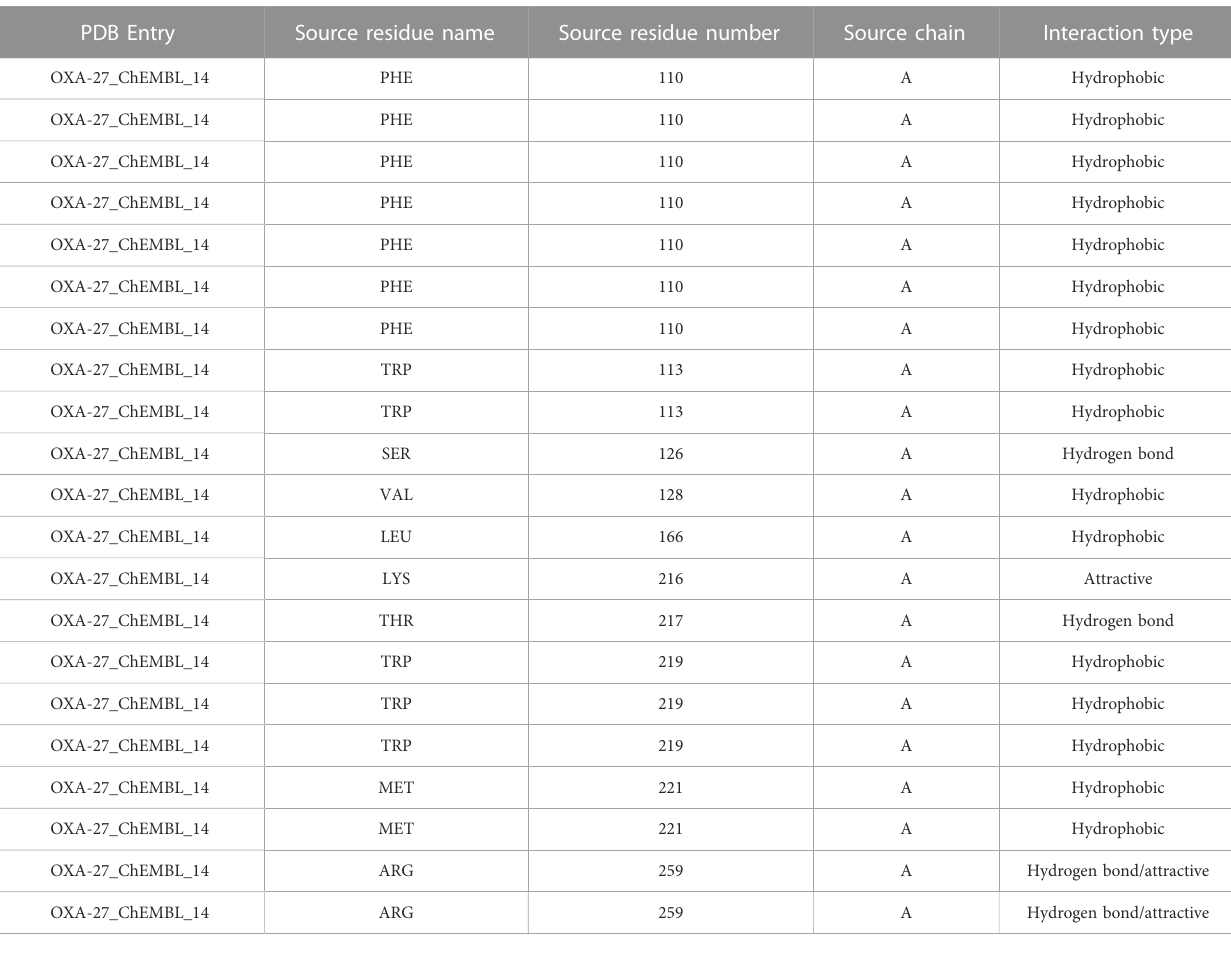
loop 1, Ser252 — Ser109 from loop 2, and Ser109 — Lys224 from loop 3 (residues taken for the measurement purpose) are shown in Figure 4. The distance of starting coordinates and initial, middle, and fi nal frames of the molecular dynamics simulation are shown in Table 6. This study suggests that the protein tends to have a wide loop opening in the absence of meropenem. The distance between the loops was smaller in the presence of meropenem in the complex, i.e., the loop regions are con fi ned. Hence, the gap between the loops is very minimal in the presence of meropenem. The OXA-23 – meropenem complex has shown the peak ranging from 0.8 to 1.8 Å by producing a median-size gap between C α and meropenem (Supplementary Figure S3). The molecular dynamics simulation reveals that Pubchem_10645796, Pubchem_25224737, and ChEMBL_14 are stable. Pubchem_10645796 was tightly bound to the protein although it has slight variation up to 30 ns and, later, it was stable throughout the simulation. Pubchem_25224737 was also constant throughout the simulation. The molecular dynamics simulation of the meropenem – OXA-27 complex has shown more fl uctuations between 0.5 and 2.0 Å from 10 to 27 ns. Later, the complex was stable after 35 ns, and it was constant till the end of the simulation. In the case of ChEMBL_14, the RMSD was found to fl uctuate throughout the simulation and increased up to 1.5 Å and maintains the close contact with the protein.